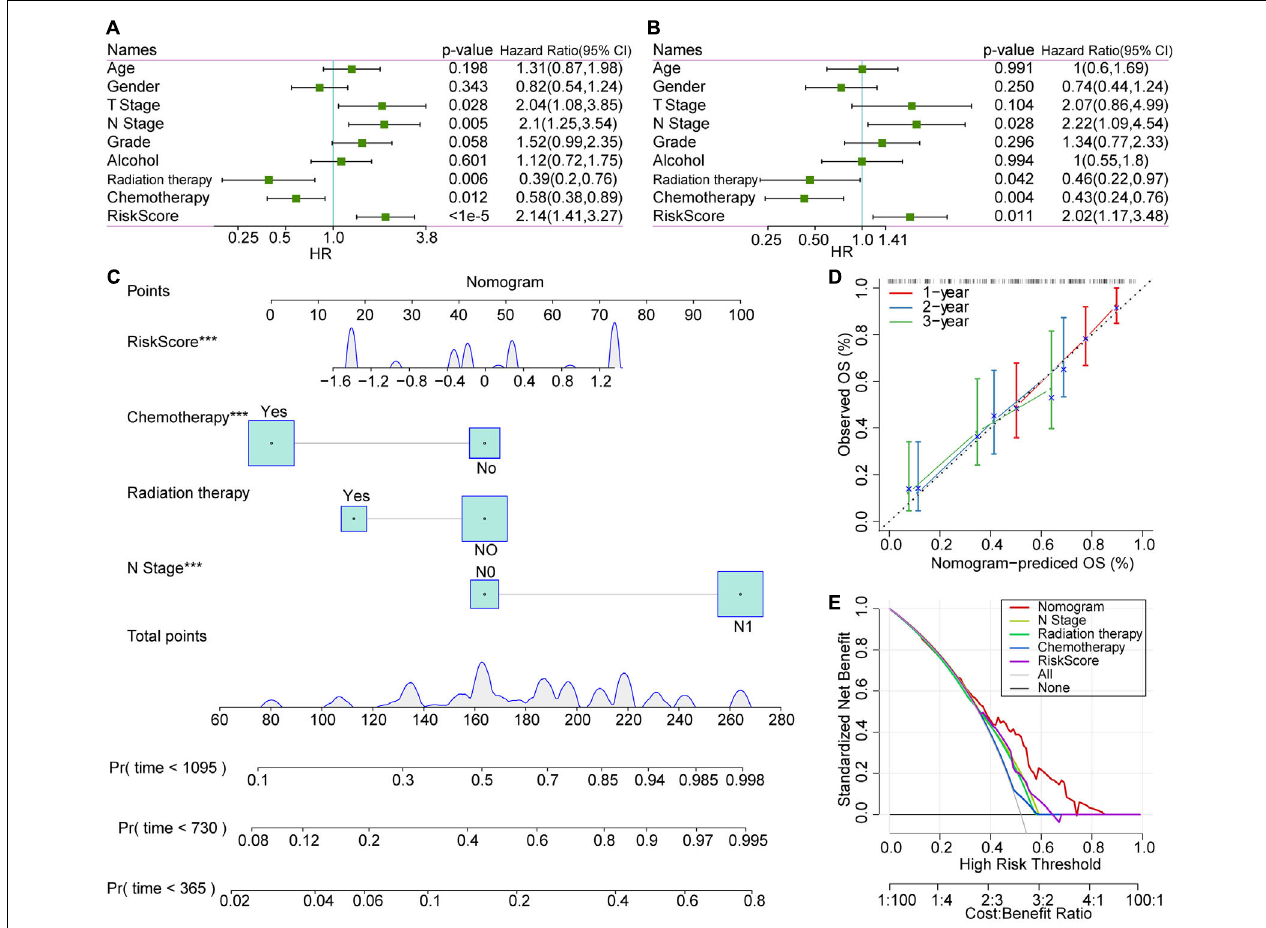
FIGURE 8 | COX analysis of RiskScores, clinical characteristics and nomogram. (A) Univariate analysis results of clinical features and RiskScore. (B) Multivariate analysis results of clinical features and RiskScore. (C) Nomogram based on clinical characteristics and RiskScore. (D) Nomogram survival rate correction chart. (E) Decision curve analysis (DCA) diagrams of N stage, radiation therapy, chemotherapy, RiskScore, and